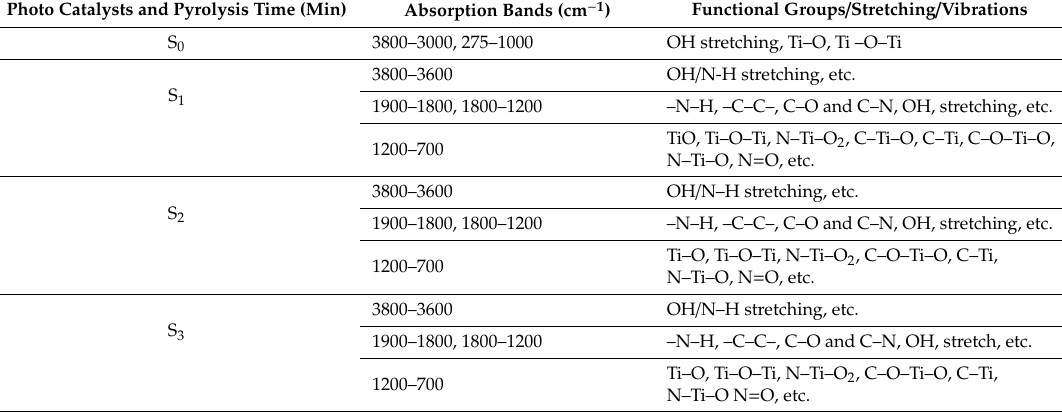
Table 2. Functional groups of the synthesised C–N–TiO 2 nano catalysts, pyrolysed with nitrogen gas at 350 ◦ C using a ramping rate of 50 ◦ C / min and held at di ff erent times 105 min (S 1 ), 120 min (S 2 ) or 135 min (S 3